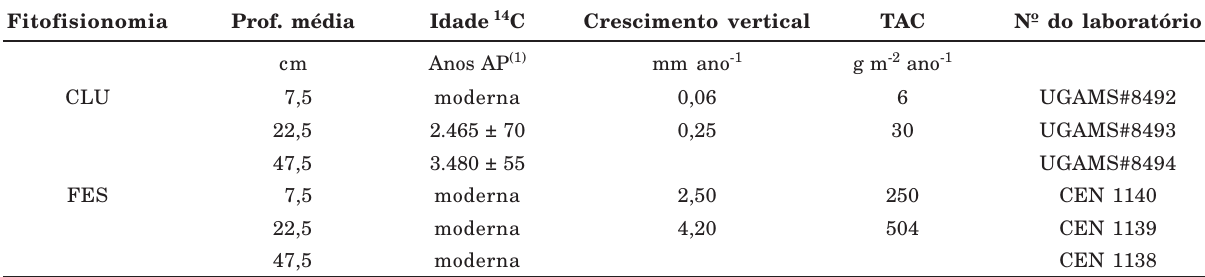
Quadro 6. Idades radiocarbônicas, crescimento vertical e taxa de acúmulo de carbono (TAC) sob as duas fitofisionomias Campo Limpo Úmido (CLU) e Floresta Estacional Semidecidual